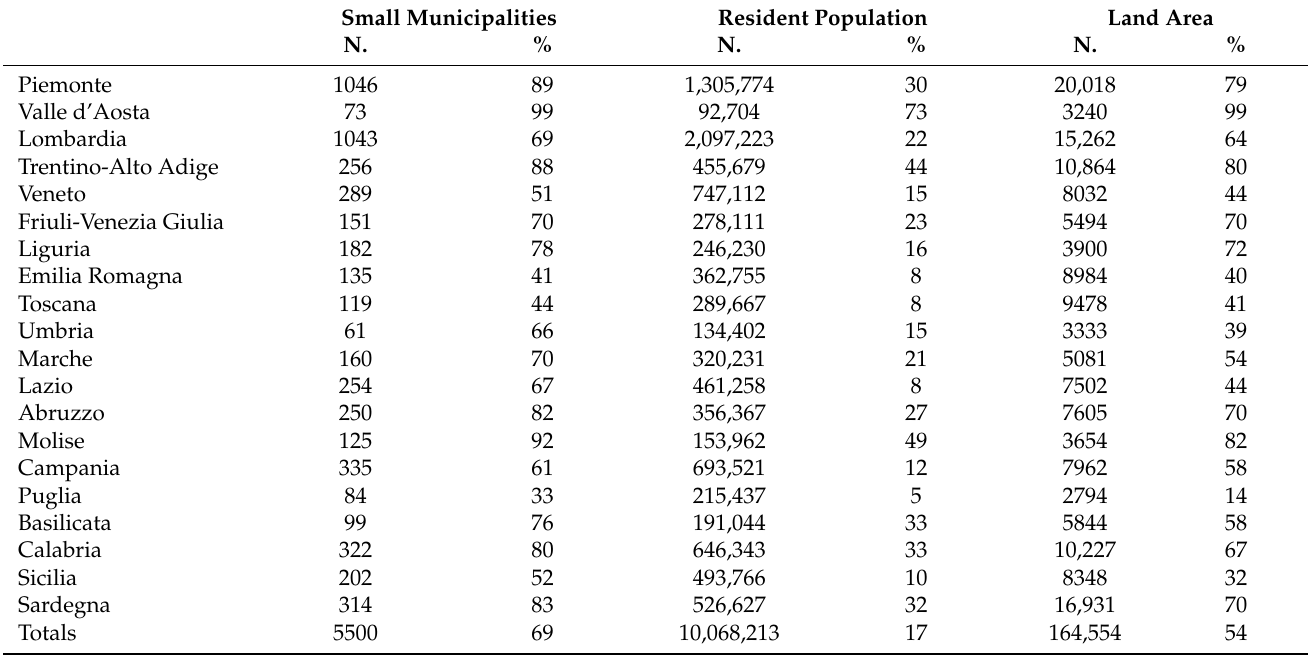
Table 6. Quantity, resident population and land area of small municipalities in Italy, year 2017 (Associazione Nazionale Comuni Italiani ANCI).